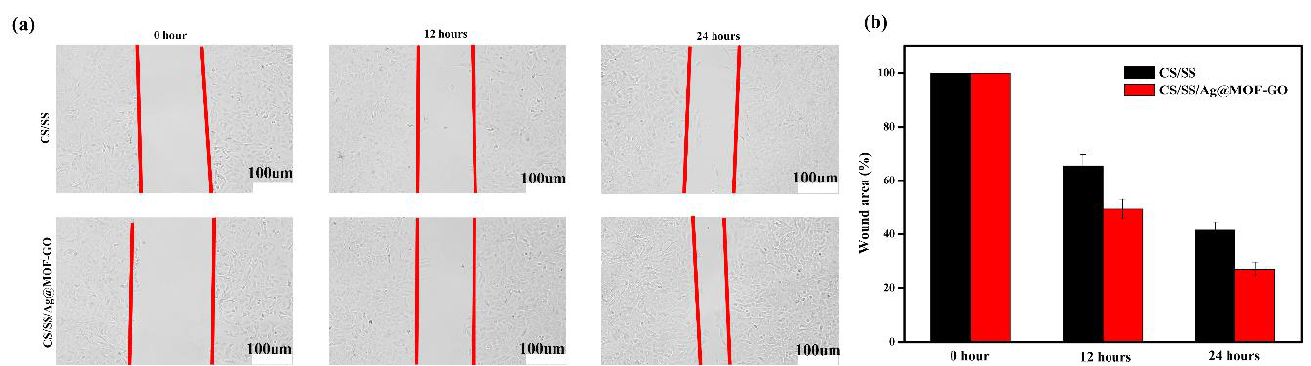
Figure 9. ( a ) Migration assay of L929 cells in presence of CS/SS or CS/SS/Ag@MOF-GO; ( b ) wound area (%).